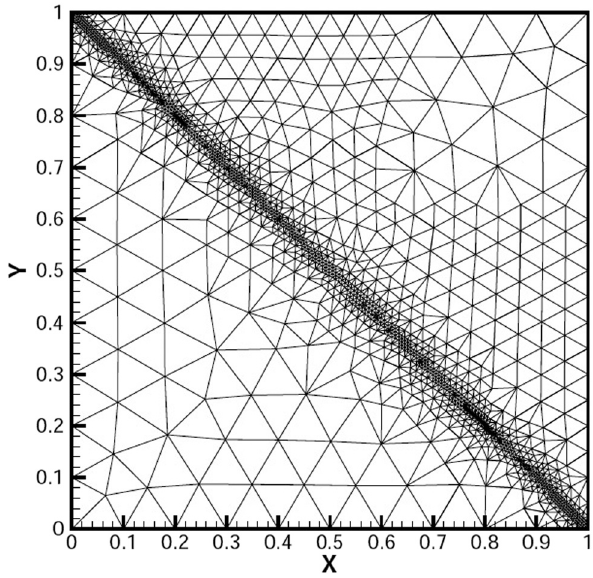
with = nodes 1,737 h h